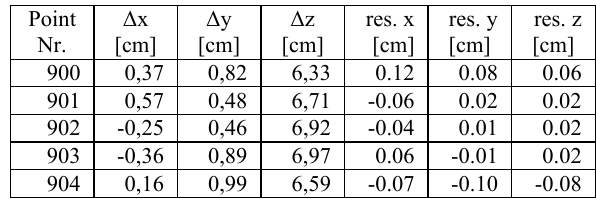
Table 2. Differences at control points before and after 3D